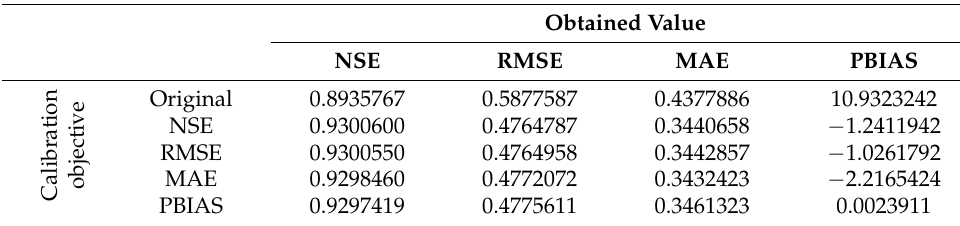
Table 4. The comparison of statistical measures before and after the calibration process of the Hargreaves–Samani equation. The first row represents the values of various statistical measures (see columns) of the original model. Remaining rows determine the objective statistical measure, which respect to the model was calibrated. The columns represent the corresponding values of various measures.